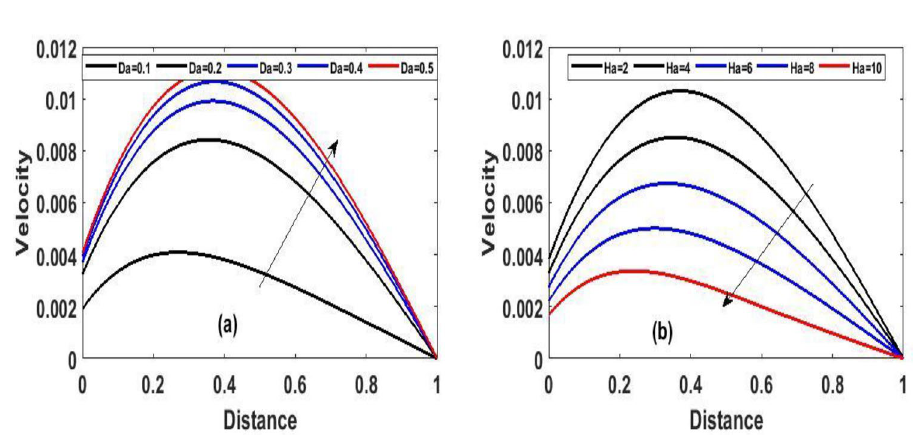
Figure 3. The effect of variation of Da and Ha for velocity steady